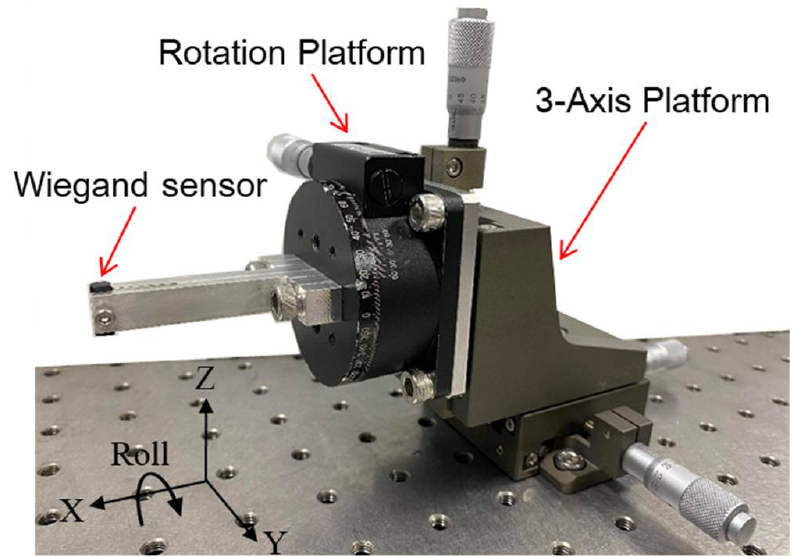
Figure 6. Schematic drawing of the comparator circuit.